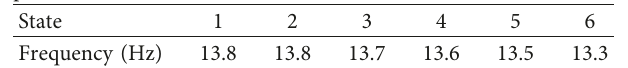
Table 2: The frequencies of beams during 6 fatigue cumulative